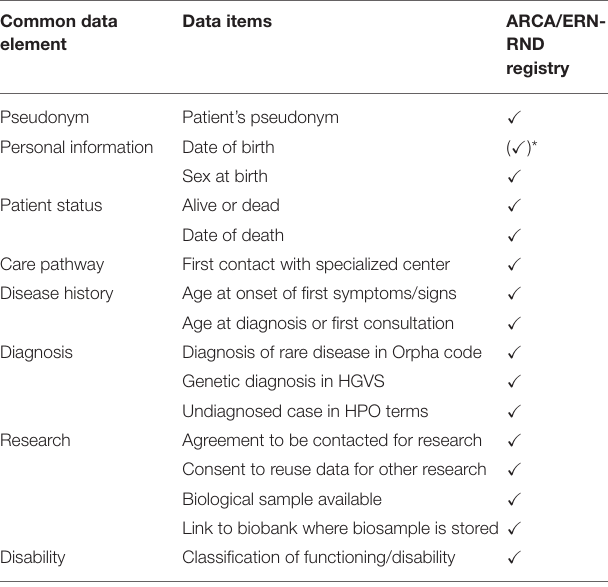
TABLE 3 | Implementation of common data elements of the EU Rare Disease platform. Common data